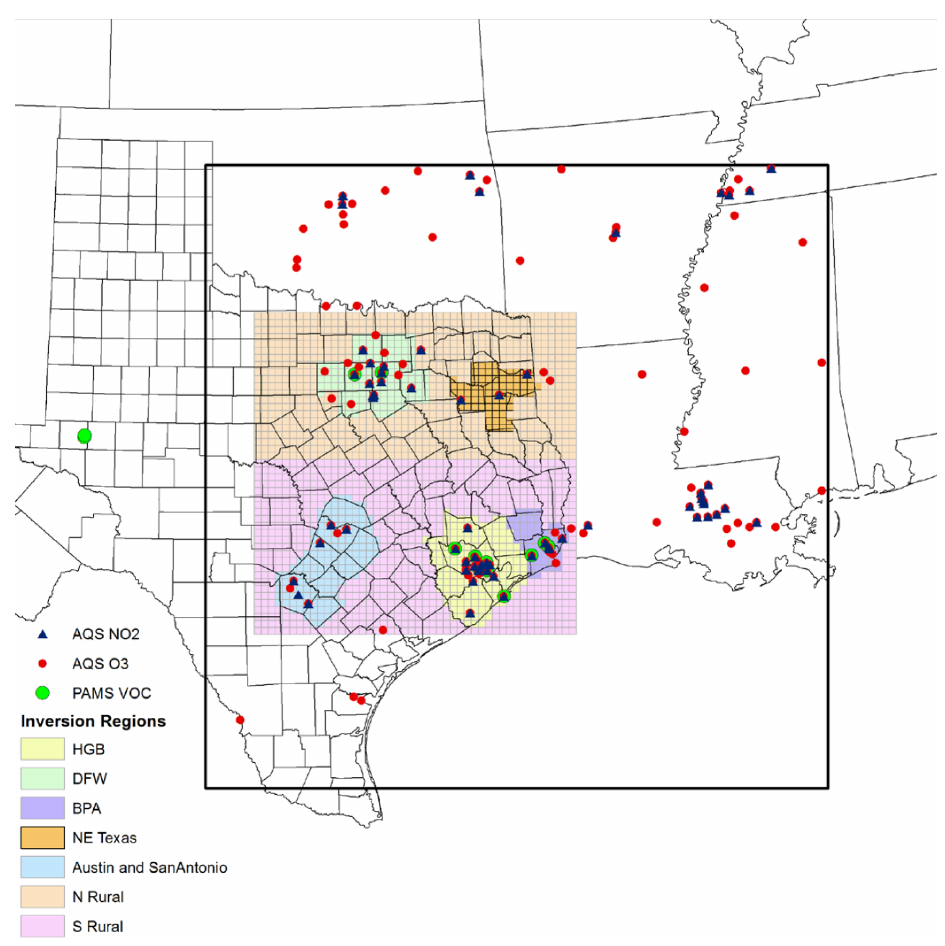
Figure 1. Seven designated inversion regions in eastern Texas (shaded) within a 12km CAMx modeling domain (black square) covered by ground NO 2 monitoring sites (blue triangles), VOC monitoring sites (green circles), and O 3 monitoring sites (red